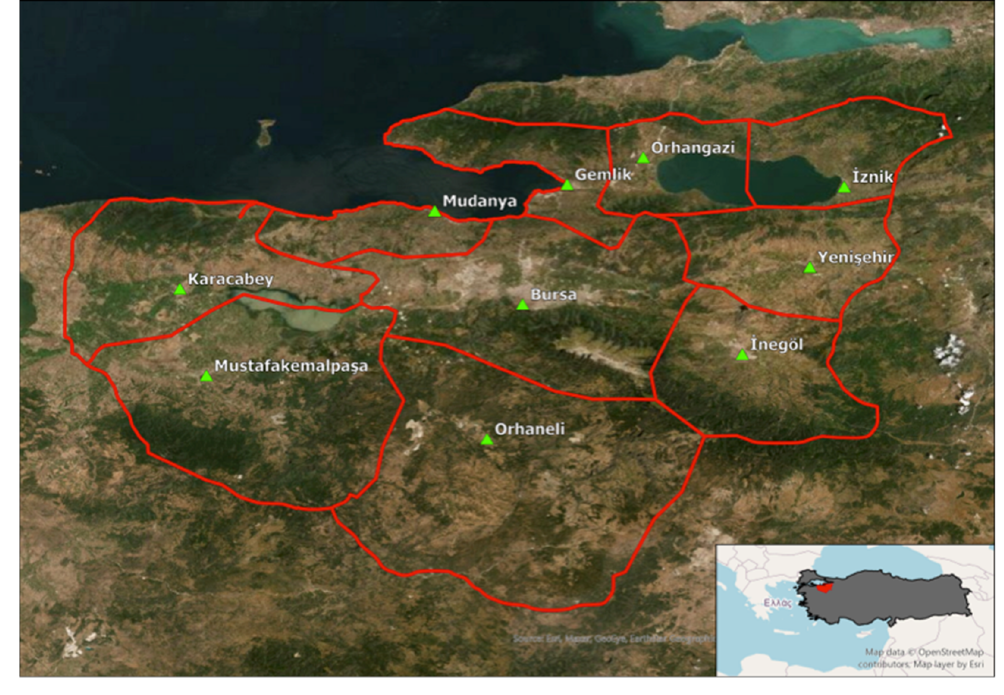
Figure 1. Map of Bursa region with administrative borders from 1935. Source: Open Street Map layer by ESRI.